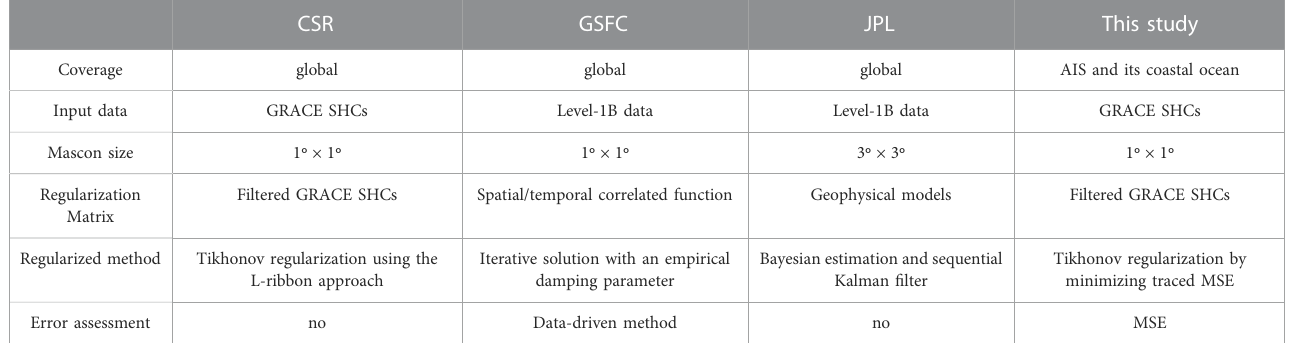
TABLE 2 Summary of the mascon solutions.